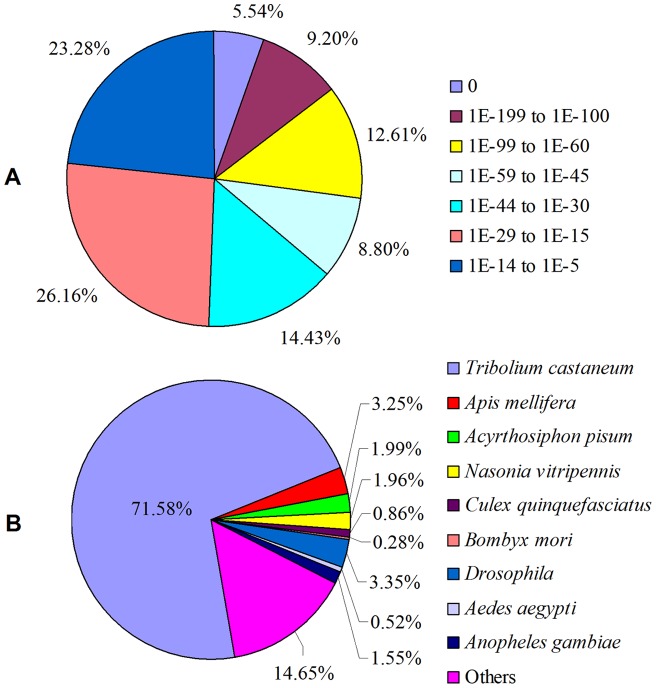
Homology analysis of Tenebrio molitor unigenes.(A) E-value distribution. (B) Species distribution. All unigenes that had BLASTX annotations within the NCBI nr database with a cut-off E-value of 10−5 were analyzed. We used the first hit of each sequence for analysis.